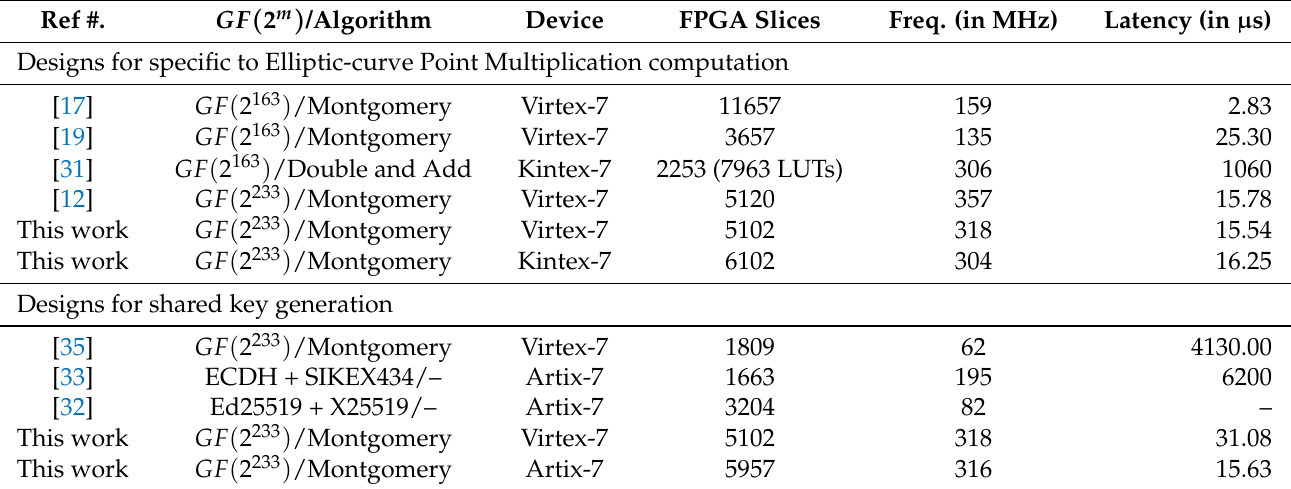
Table 3. Comparison to state-of-the-art architectures over 7-series FPGA